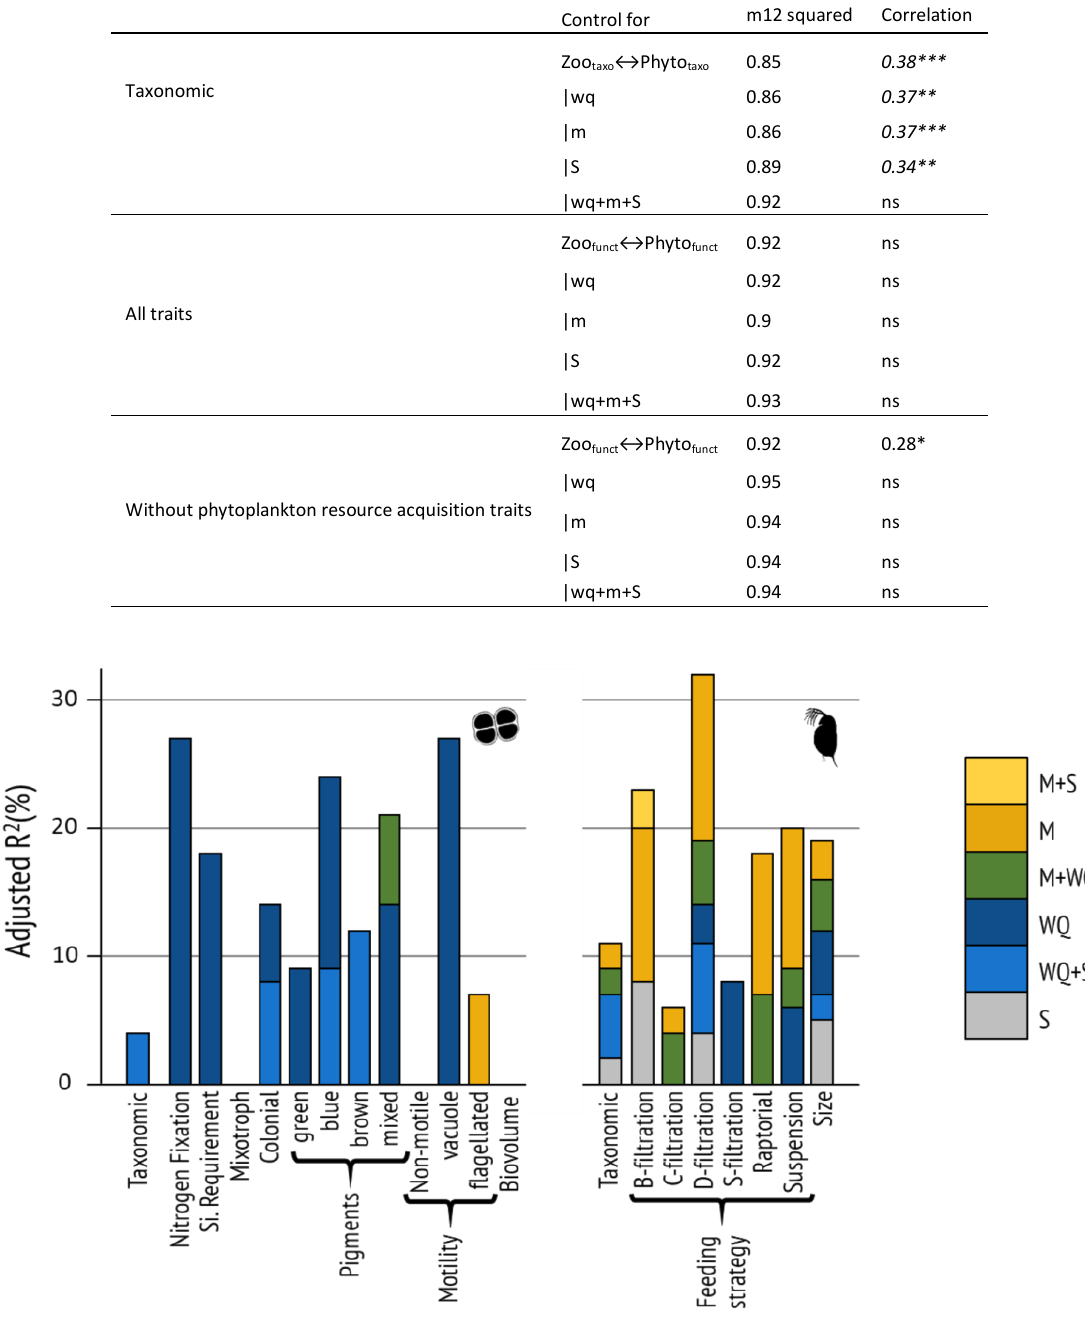
Figure 5: Variation explained (adjusted R 2 ) by environmental and spatial factors for phytoplankton (left panel) and zooplankton (right panel) taxonomic composition and each functional trait. Only regression and RDA models that were globally significant are displayed. The variation that was independently explained by a group of variables is represented if significant, and shared variation represents the sum of variation shared between any of the groups of variables, represented with a